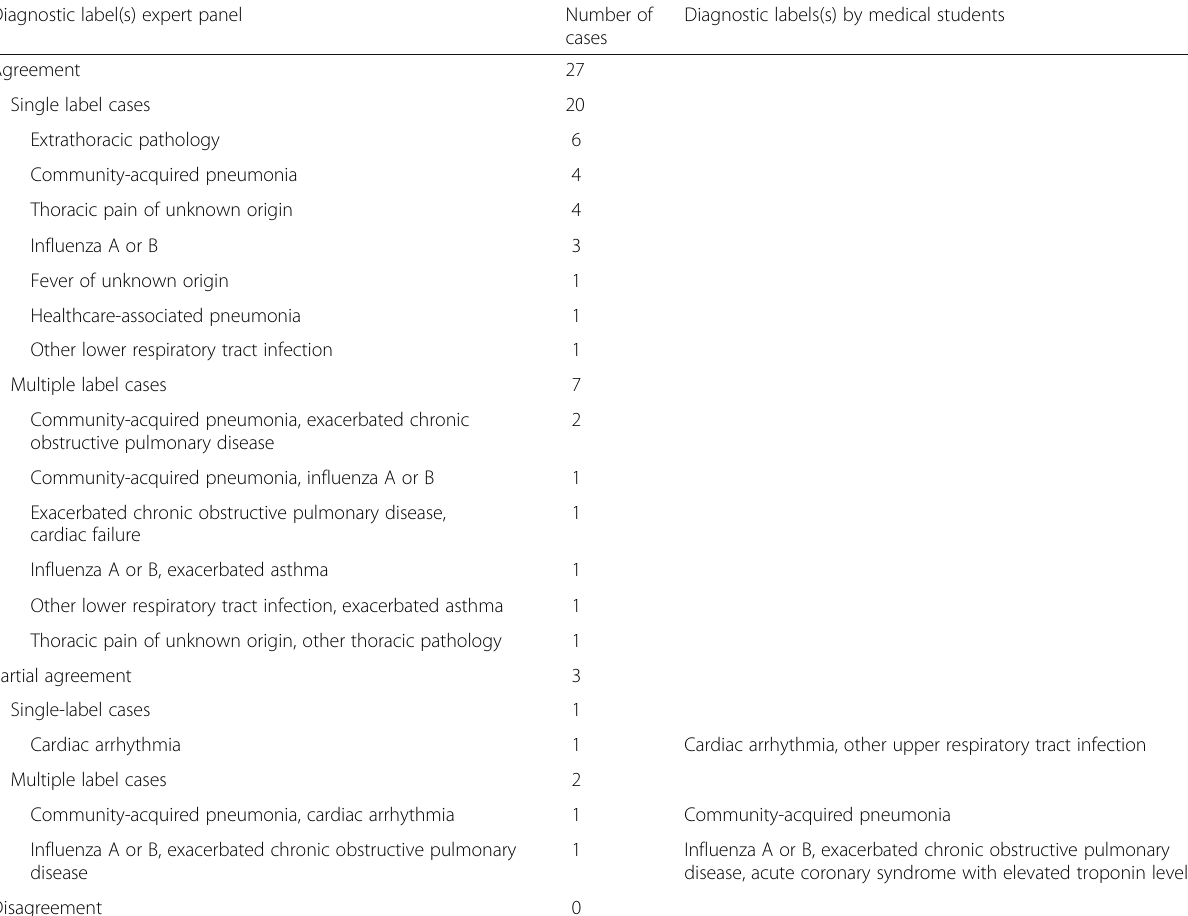
Table 1 Classification by medical students as compared to classification by the expert panel ( n = 30) Diagnostic label(s) expert